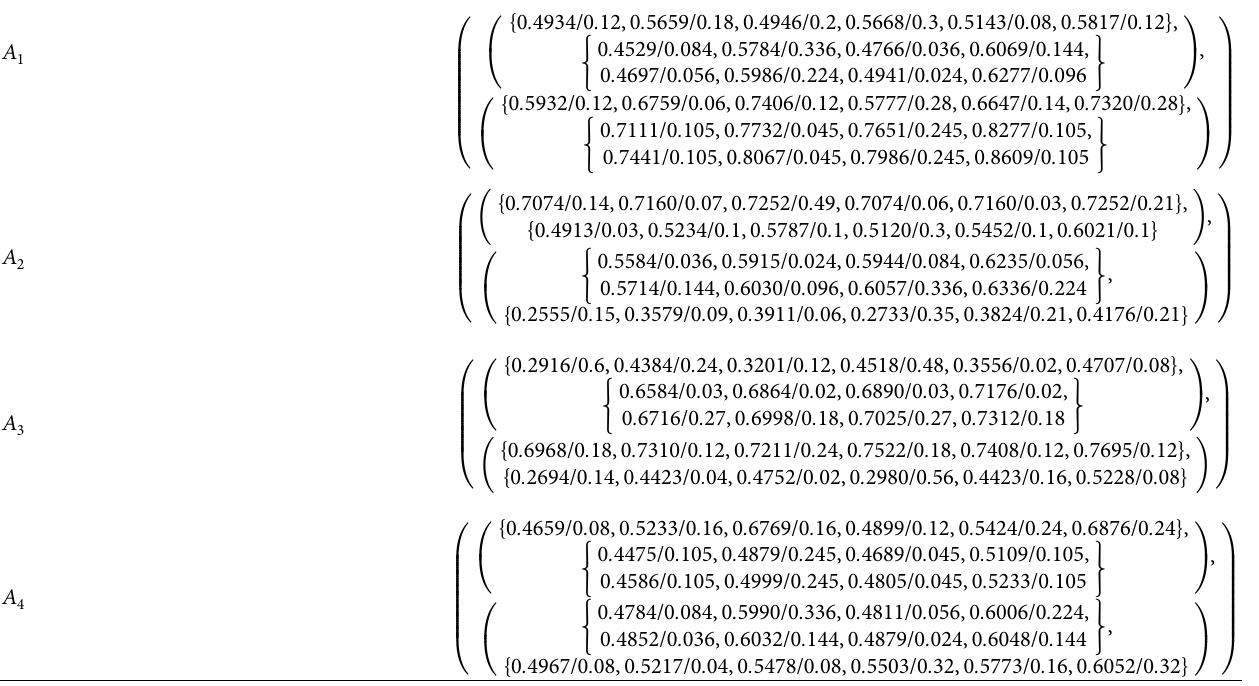
Table 3: Aggregated information using q -ROPHFREWA.